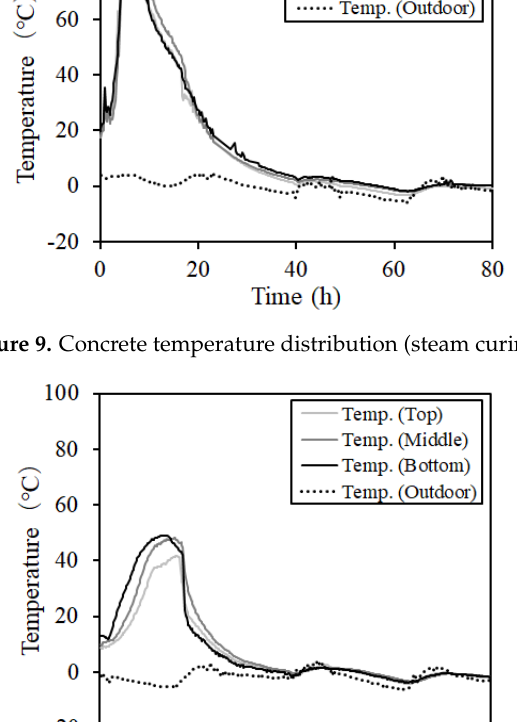
Figure 11. Concrete surface temperature distribution. ( a ) Steam curing ( b ) MW heat curing (ex: MW2). 3.2.2. Strength Properties (Core Strength) Figure 12 shows the compressive strength of the core specimen, which was a simulated member. Steam curing exhibited higher initial strength compared to MW heat curing. However, it was less than 10% after 14 days because of the small increase in strength after steam curing. Figure 13 shows the relationship between the total temperature and compressive strength after removing the form. Concrete strength was strongly influenced by the curing temperature. In the case of steam curing, the initial strength increased because the initial curing temperature was high. However, the initial curing temperature should not be increased sharply because it decreases long-term durability and causes problems, such as the occurrence of cracks and a decrease in strength development. In addition, the demolding strength of spotted concrete (5 MPa) specified in JASS5 of the Architectural Institute of Japan is exceeded in steam curing and MW heat curing at the time of removing the form. However, a demolding strength of 10 MPa or more is required considering the onsite environment of large- sized PCa product movement at PCa factories, etc. In addition, it was considered that the curing condition of MW3 is more advantageous based on the strength development after demolding and the durability degradation in the experimental conditions.